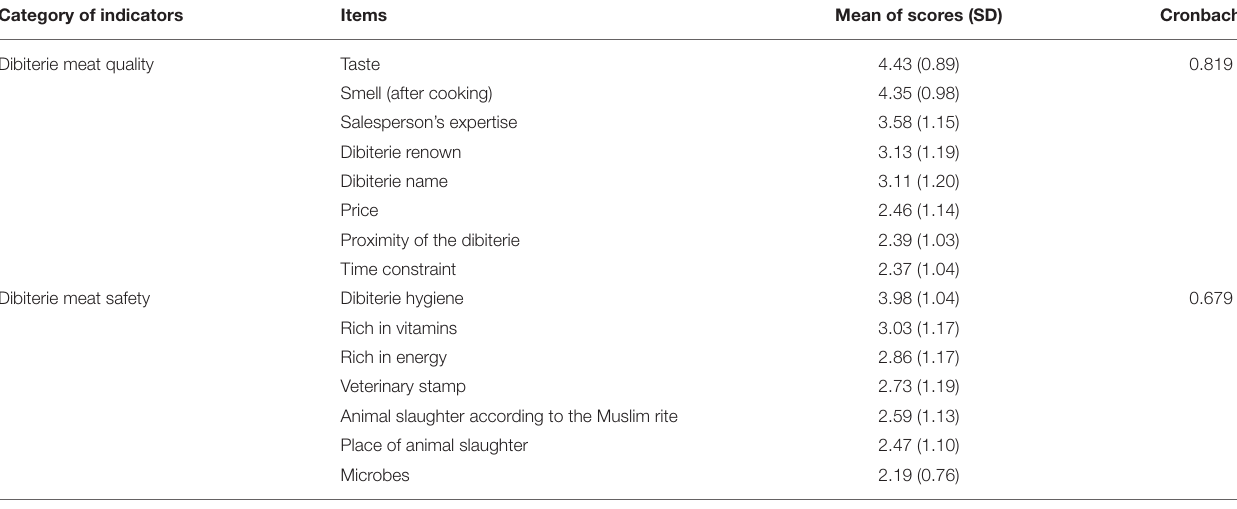
TABLE 2 | Distribution of the mean scores of the indicators of perception on the quality and safety of dibiterie meat ( n = 291). Category of indicators